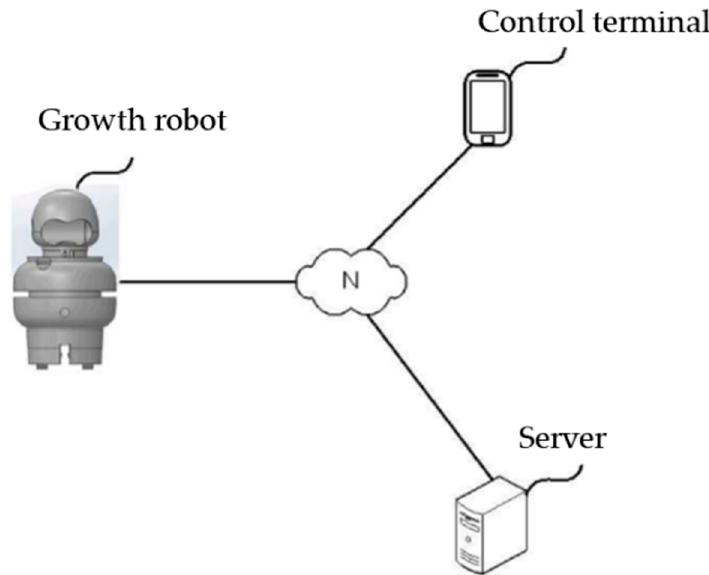
Figure 5. The network linked among the growth robot, the control terminal, and the server.